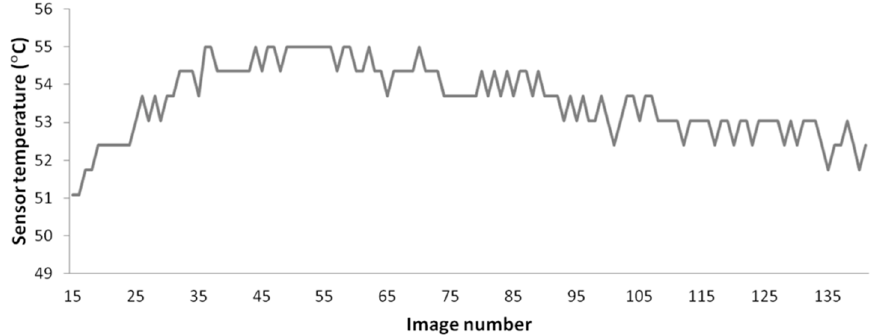
Figure 17. Temperature of the Sequoia camera during the flight on 22 September 2020. Images captured before takeoff are not included. The camera reached a temperature of 54 °C before the first image included in the reflectance map was captured.